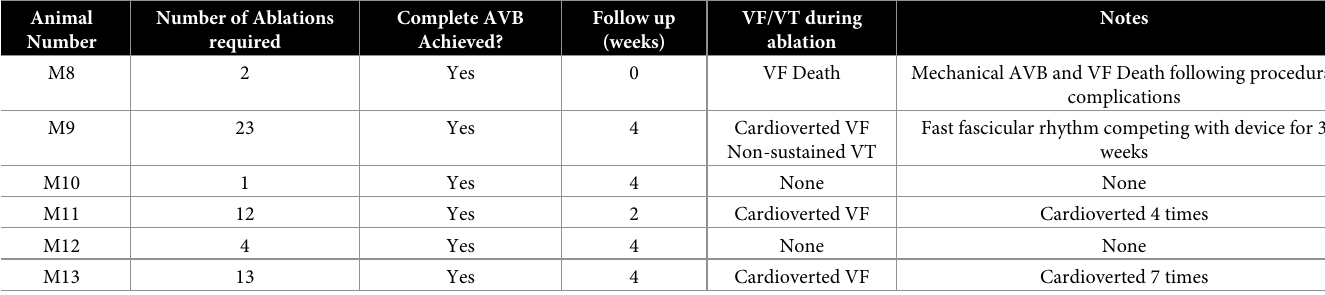
Table 2. Summary of experimental data and outcomes of RF ablation experiments performed in sheep to create AVB. Animal Number of Ablations Number